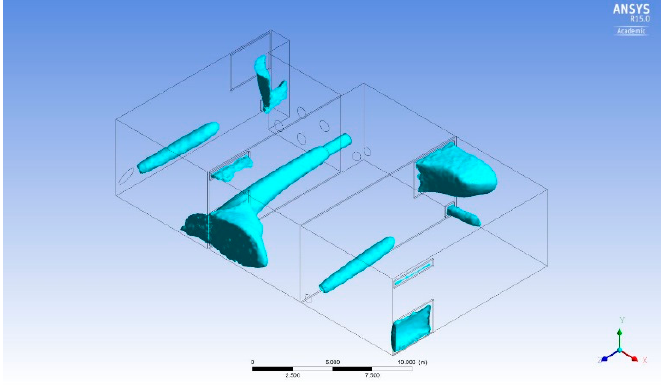
Figure 19. Existing mixer velocity plot 0.2 m/s and greater.